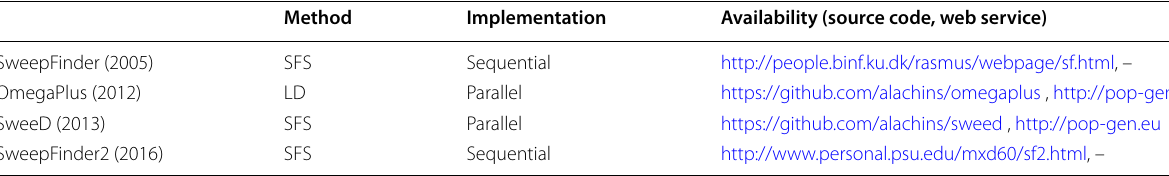
Table 1 List of software tools for selective sweep